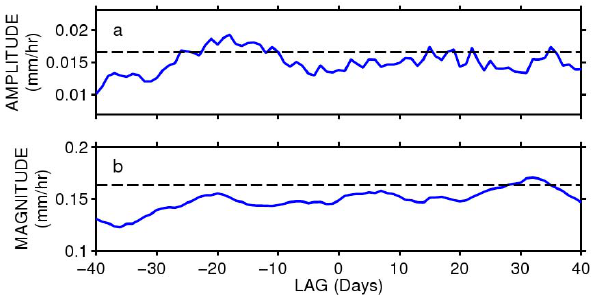
Fig. 19. (a) The average amplitude of E1 oscillations in the TRMM precipitation data at the same periods and times (with various lags added) at which UFKW are present in the Aura MLS data. (b) The average zonal-mean magnitude of precipitation rate in the TRMM data before (positive lag), during (zero lag) and after (negative lag) the times at which UFKW are present in the Aura MLS data. The dotted lines represent the average over all times, not just the times either side of the large-amplitude mesospheric UFKW